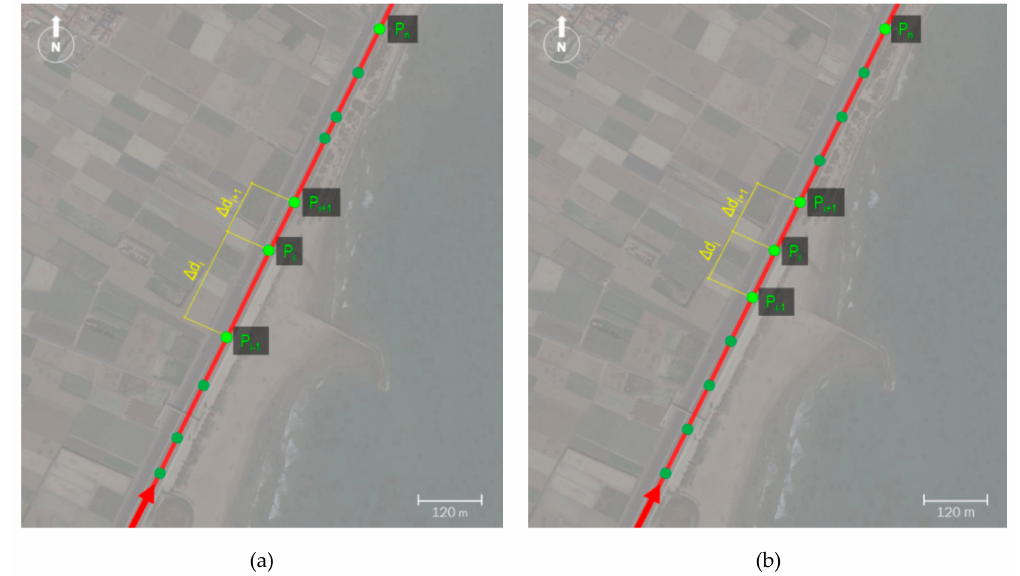
Figure 2. Point array distributed along the road path: ( a ) Actual, and ( b ) theoretical distribution.